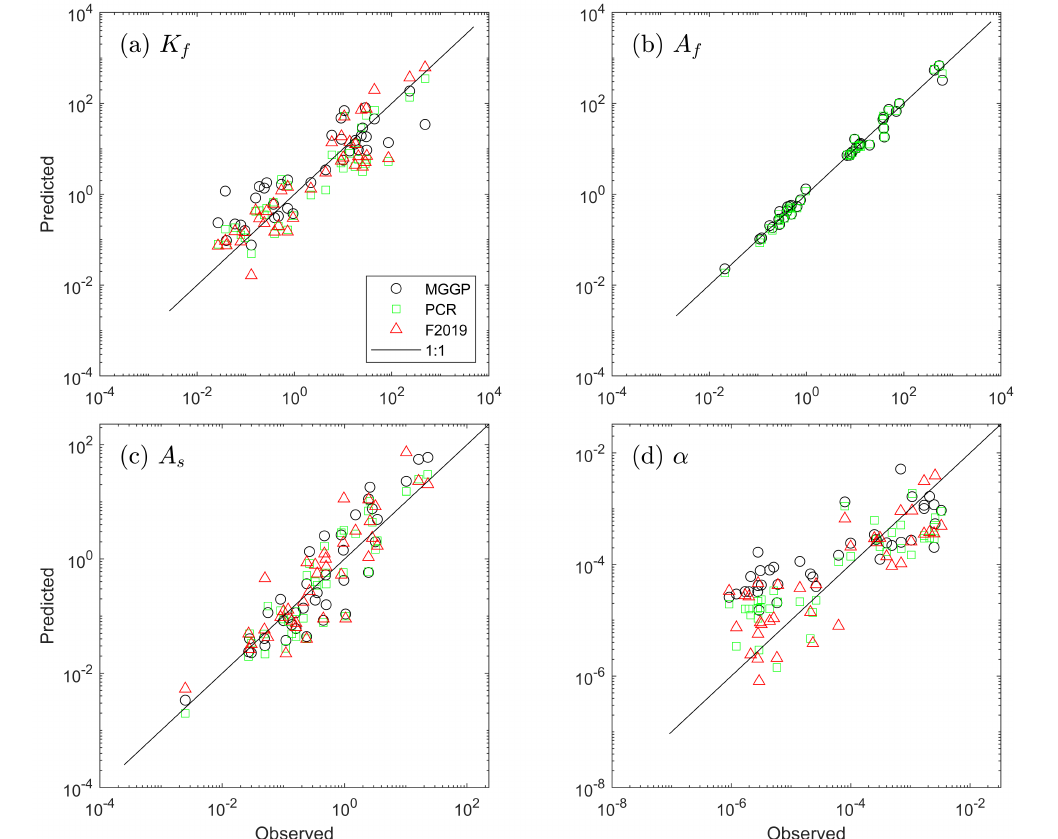
Figure 10. Observed parameter values versus predicted values by empirical equations for the test set; ( a ) K f . ( b ) A f . ( c ) A s . ( d ) α .